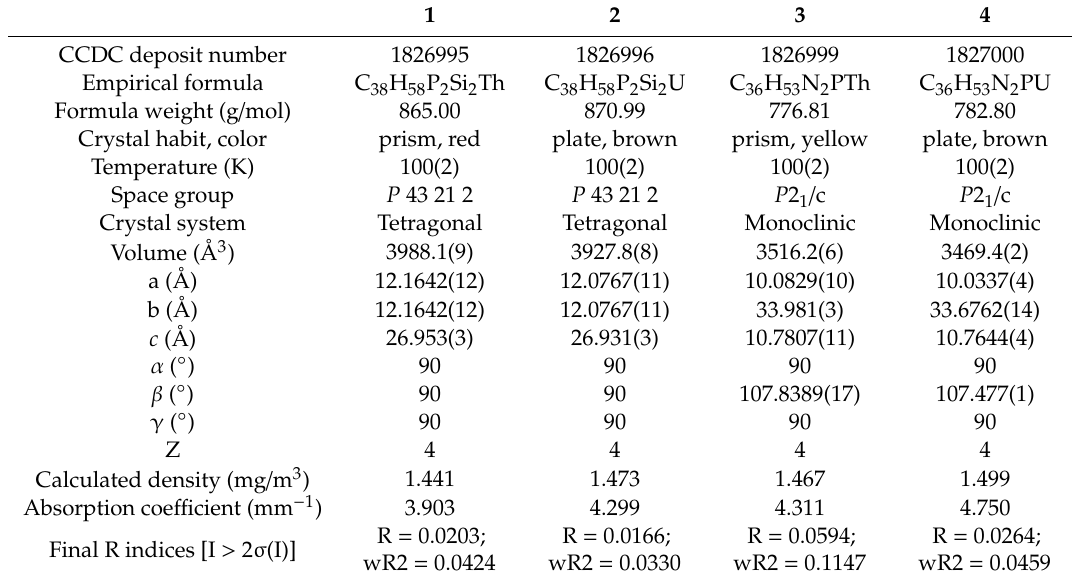
Table 2. Crystallography parameters for complexes 1 – 4